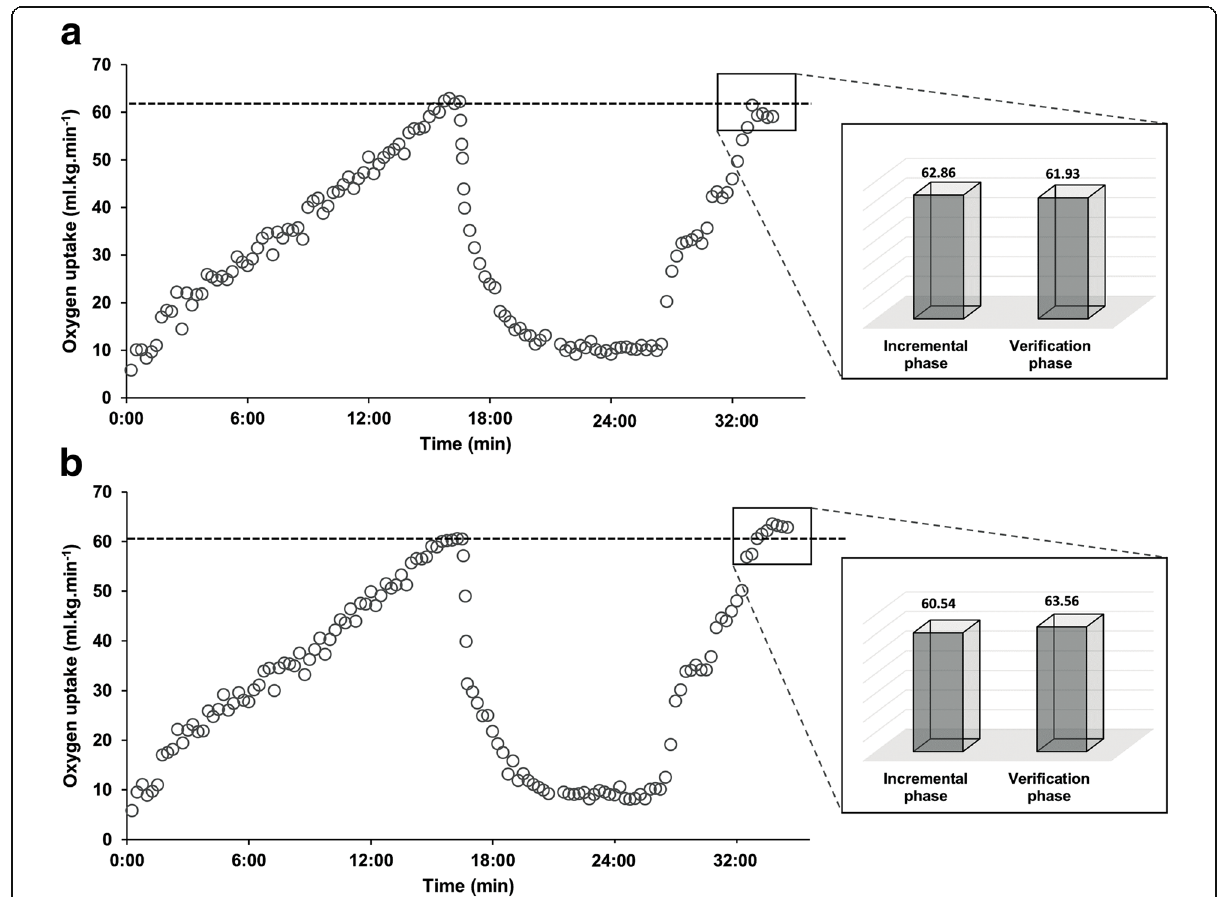
Fig. 2 Oxygen uptake (V ̇ O 2 ) responses to an incremental test followed by a multistage verification phase for two representative subjects. a represents a valid test, while b represents a test were verification phase maximal oxygen uptake (V ̇ O 2max ) was higher than that reached during incremental phase, consequently, an invalid test. Note: differences between phases were considered as V ̇ O 2 differences > 2%; > 3%; > 2.2 or 2.0 ml kg − 1 min − 1 and V ̇ O 2 values presented as 15-s